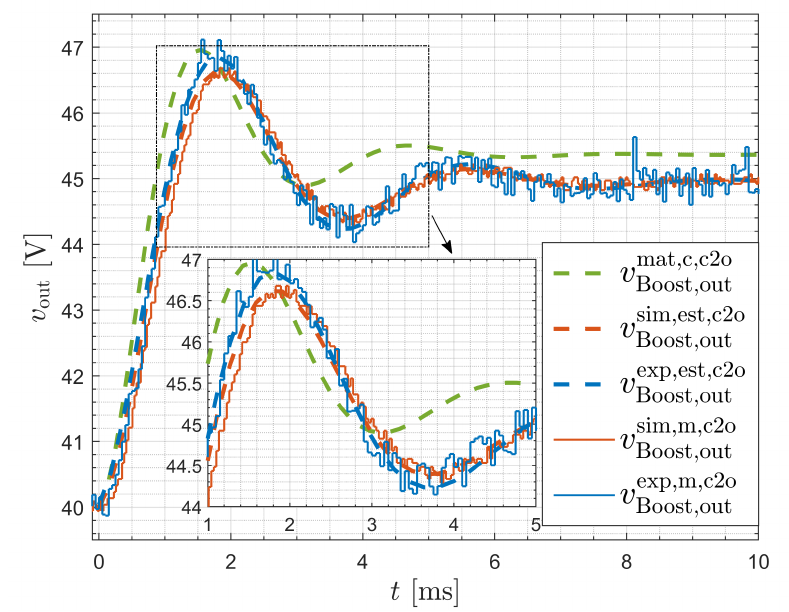
Figure 4. Step responses of considered control-to-output transfer-functions: mathematical ( s ) ( s ) corresponding to v mat,c,c2o P mat,c,c2o , simulation P sim,est,c2o corresponding to v sim,est,c2o and Boost Boost,out Boost Boost,out ( s ) corresponding to v exp,est,c2o = 30 V and the duty experimental P exp,est,c2o . Recorded at V rtd Boost,in Boost Boost,out cycle, D step change corresponding to the output transition from V Boost,out = 40 V to around = 45 V . For comparison purpose the simulation, v sim,m,c2o V rtd , and experimental, v sim,m,c2o , Boost,out Boost,out Boost,out measurements have been shown